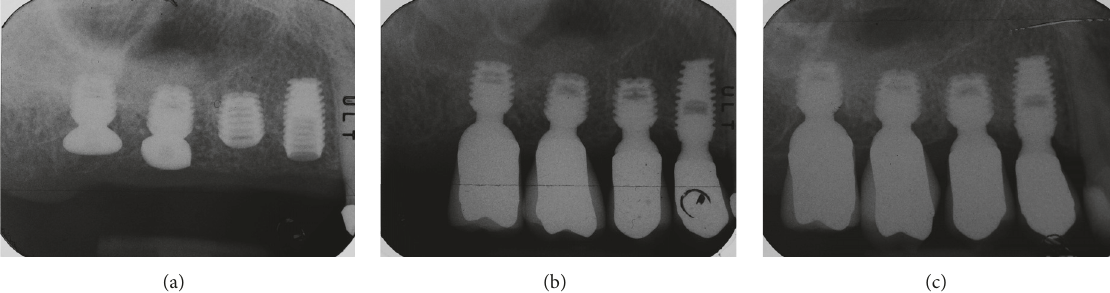
Figure 2: (a) Immediate postoperative radiography of premolar implants placed at the upper posterior maxilla (premolars); internal sinus lift cases were not included in this study. (b) Immediate X-ray obtained at crown insertion. (c) X-ray obtained at three-year follow-up showing the implant-restoration